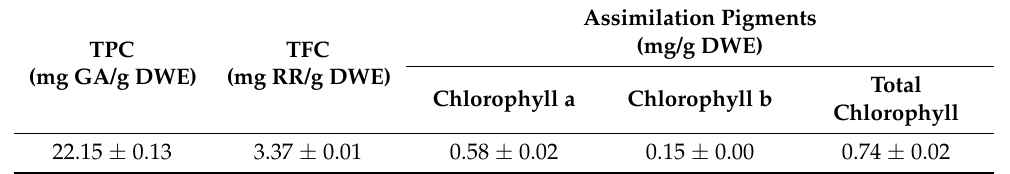
Table 2. Total contents of the polyphenols (TPC) and flavonoids (TFC) assimilation pigments in the ethanolic extracts from E. angustifolium (FEE). The contents of the phenolic compounds were determined using gallic acid (GA) and flavonoids using quercetin (QE). Values are the mean of three replicate determinations ( n =